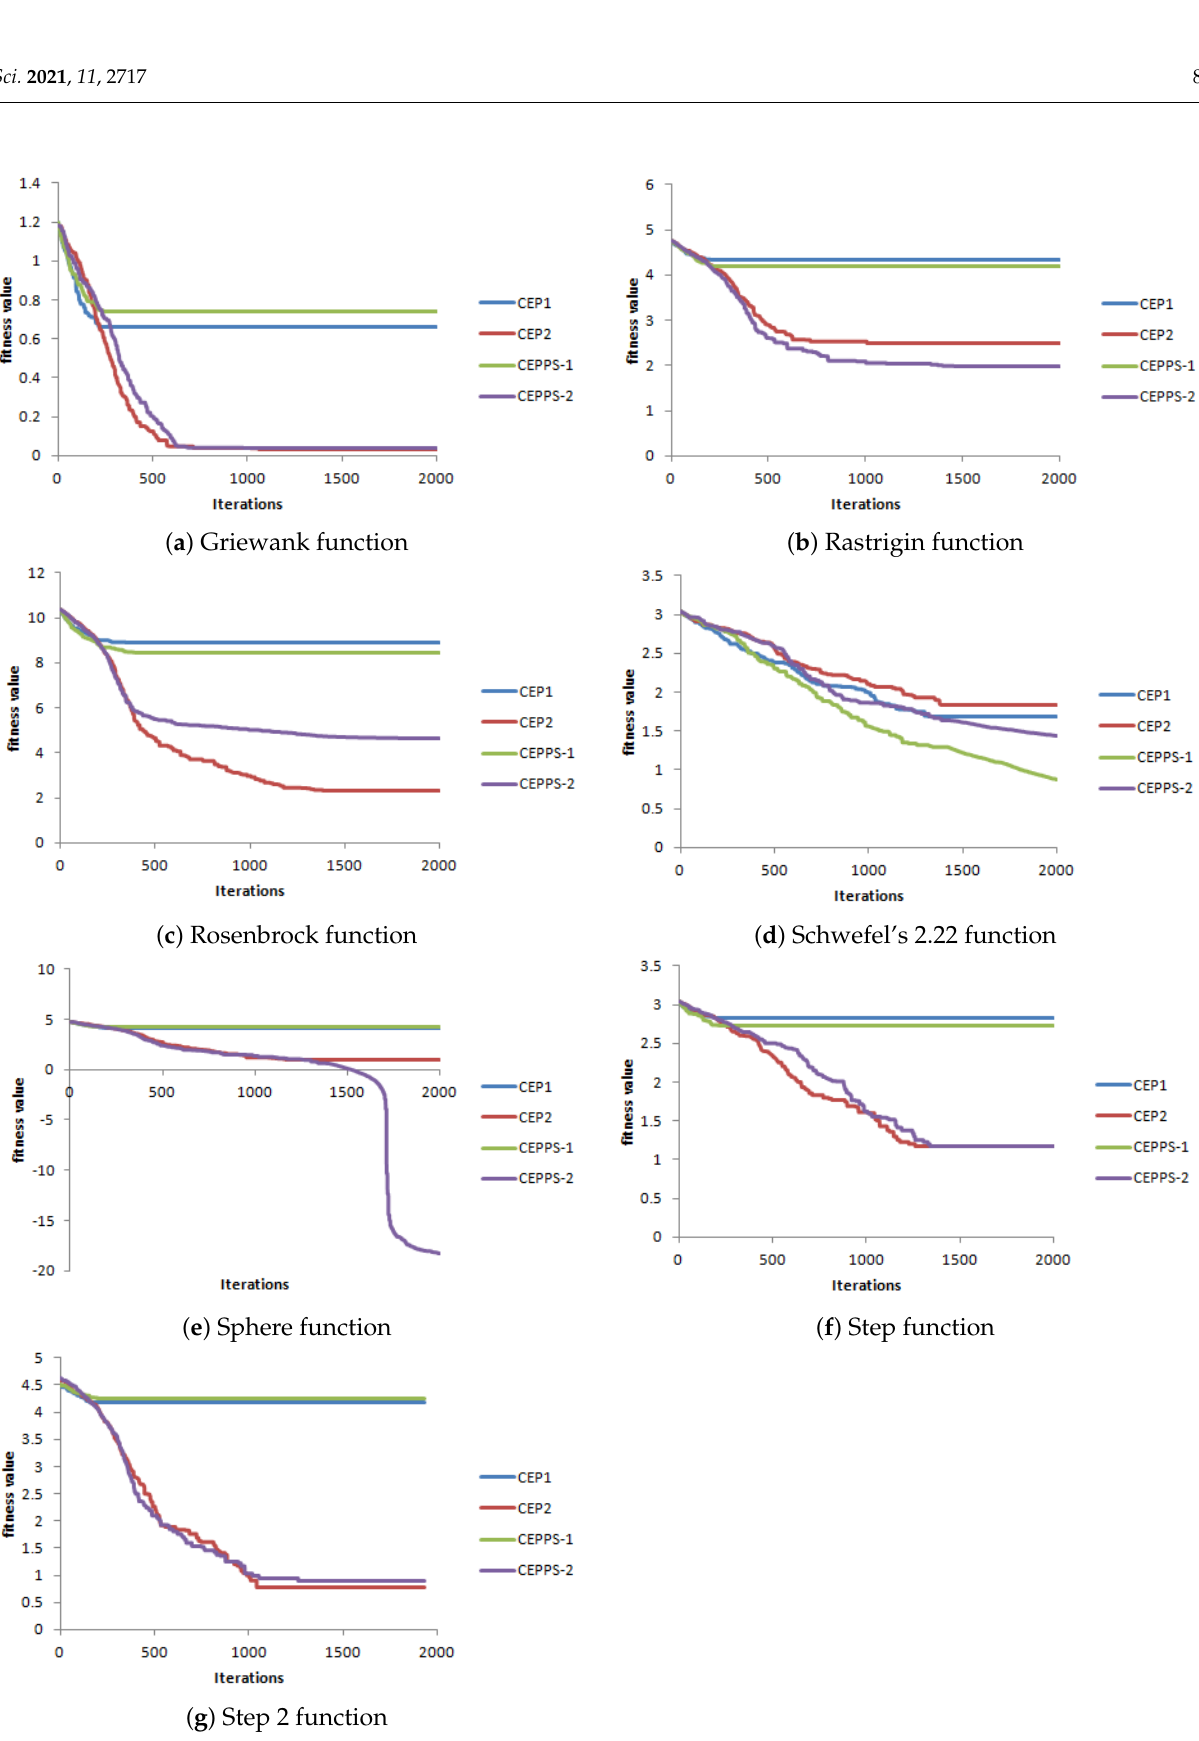
Figure 2. Convergence behaviors of the different test